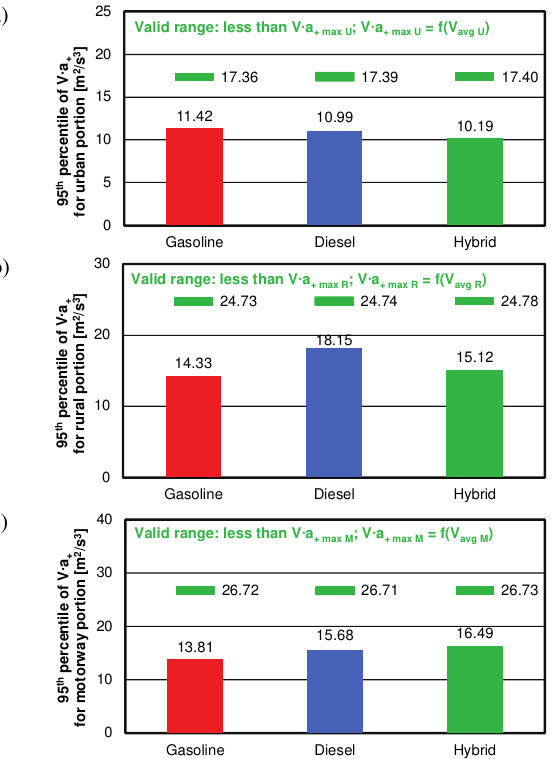
Fig. 13. Vehicle speed and acceleration product 95 th percentile comparison of urban (a), rural (b) and motorway (c) test vehicles with the maximum value (required) for all